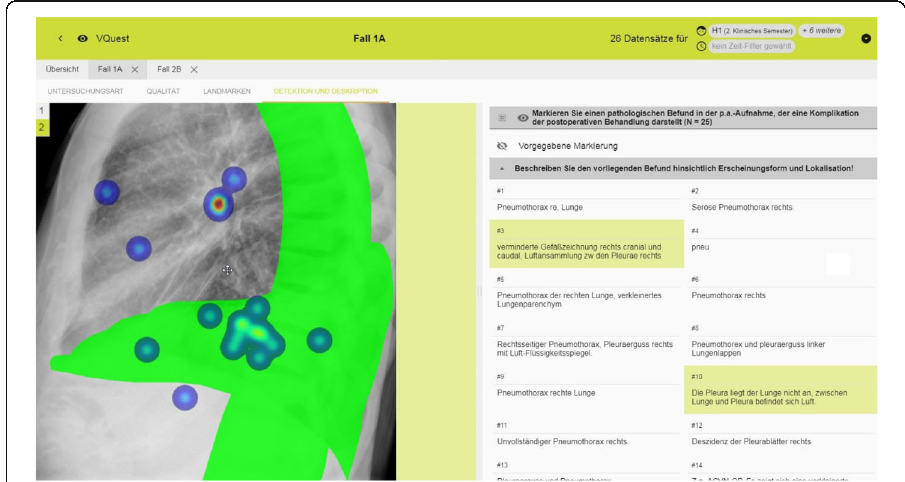
Fig. 4 Learning dashboard used in a class-wide discussion showing a hotspot diagram of student responses on a marker question in prior computer tasks. Cursor indicates panning. Numbers in the upper left margin of the radiograph are for switching between images. The green areas in the radiograph indicate the correct target area and can be made invisible with the “ hide correct answer ” button (eye